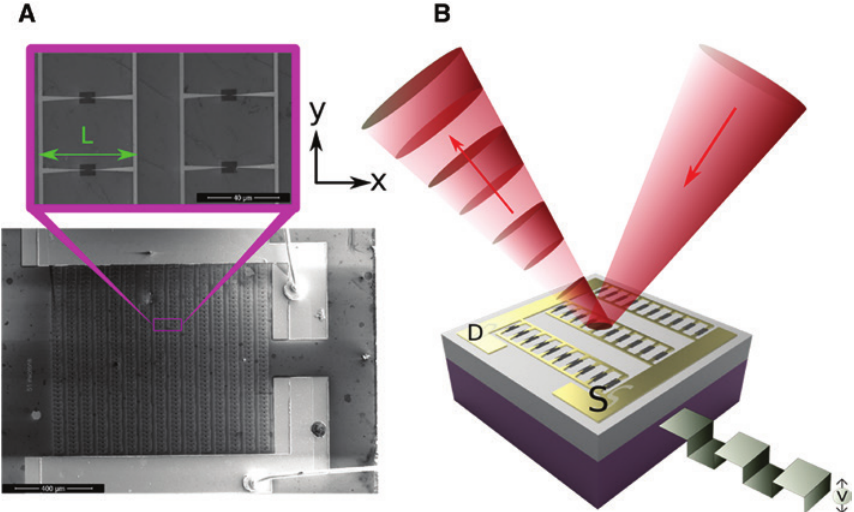
Figure 7: (A) SEM image of the device. The interdigitated scheme is based on metallic bow tie fabricated with two metals with different work functions, namely, Pd and Ti, shorted by rectangular regions of graphene, as clearly seen in the inset. (B) Basic operating principle of the device. The device can be operated both as a modulator [68] and as a detector [13]. Reprinted from Jessop et al. [68], with the permission of AIP